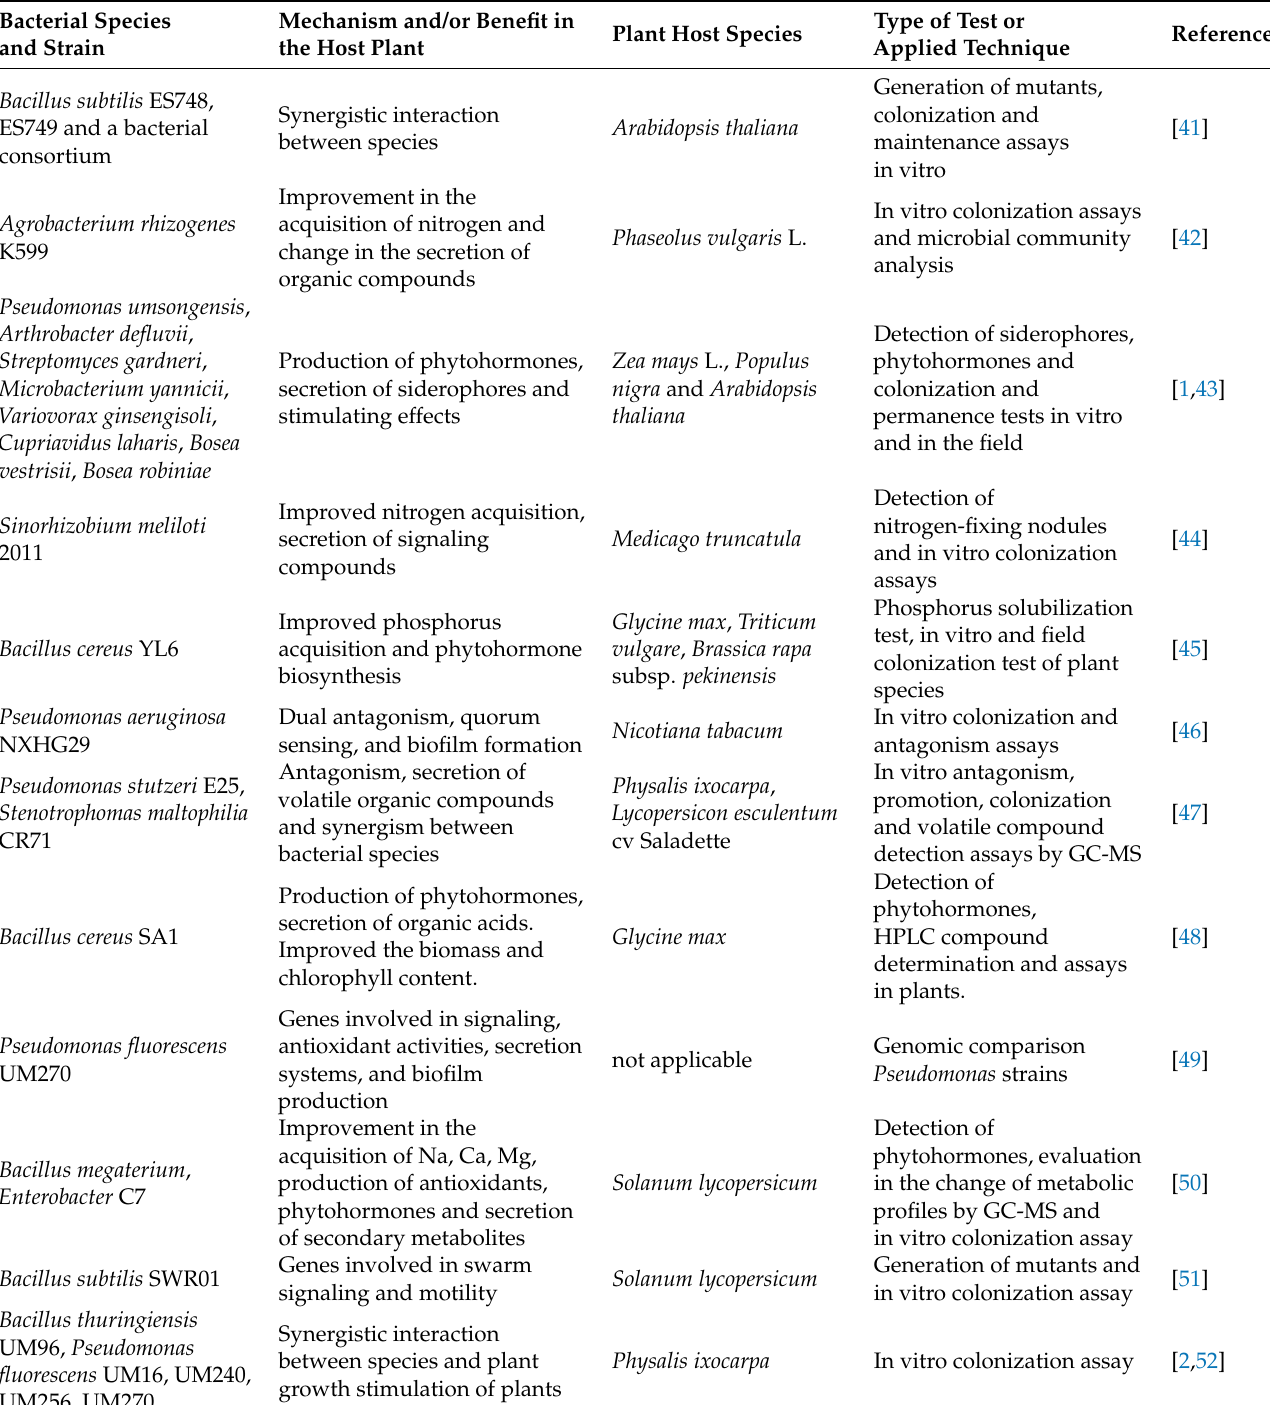
Table 1. Examples of works highlighting direct and indirect mechanisms of biocontrol and plant-growth promotion in plant-associated